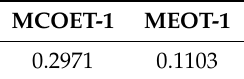
Table 1. Averaged computation time (seconds) for one run (90 steps) of two approaches in scenario A.